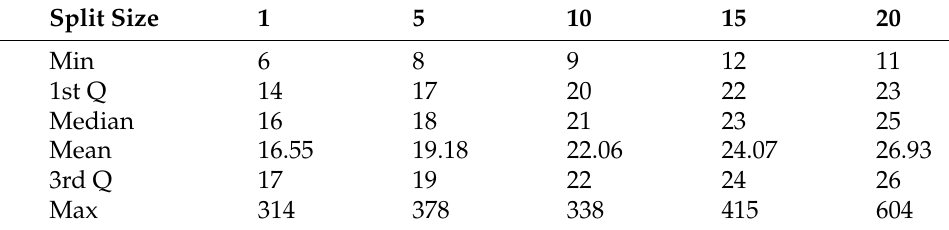
Table 3. Statistics of publisher delay in Figure